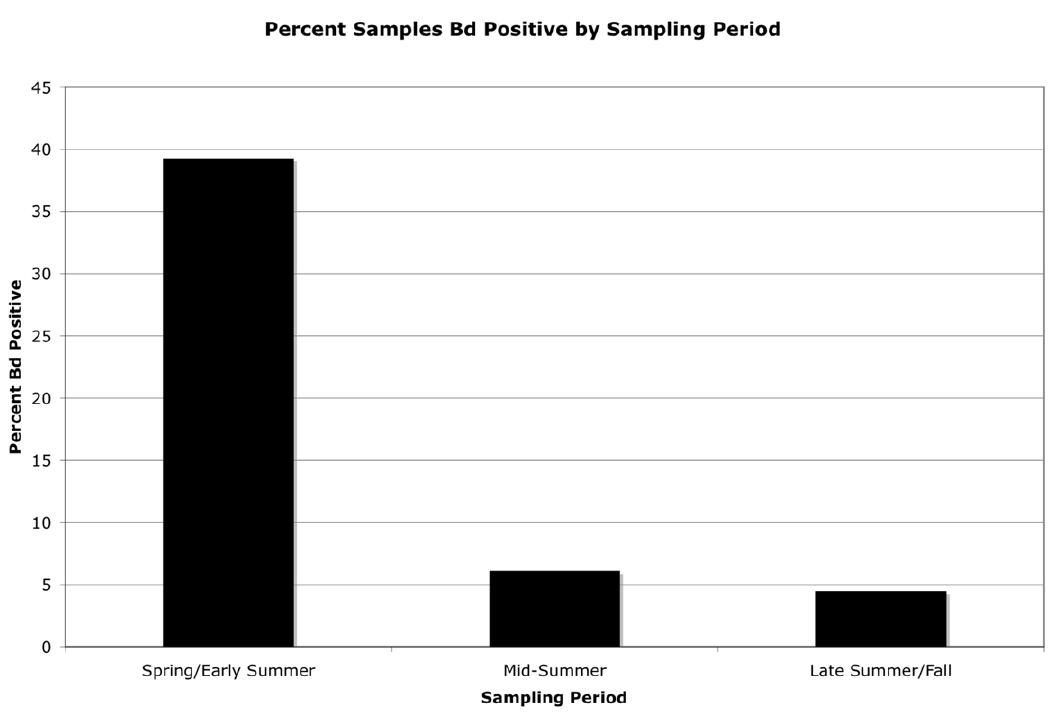
Figure 3. Temporal pattern (seasonality) of Bd infection incidence across all installations. Note the strong tendency for the highest incidences to occur during the spring/early summer sampling period, followed by a precipitous drop off during the mid- to late-summer and fall.